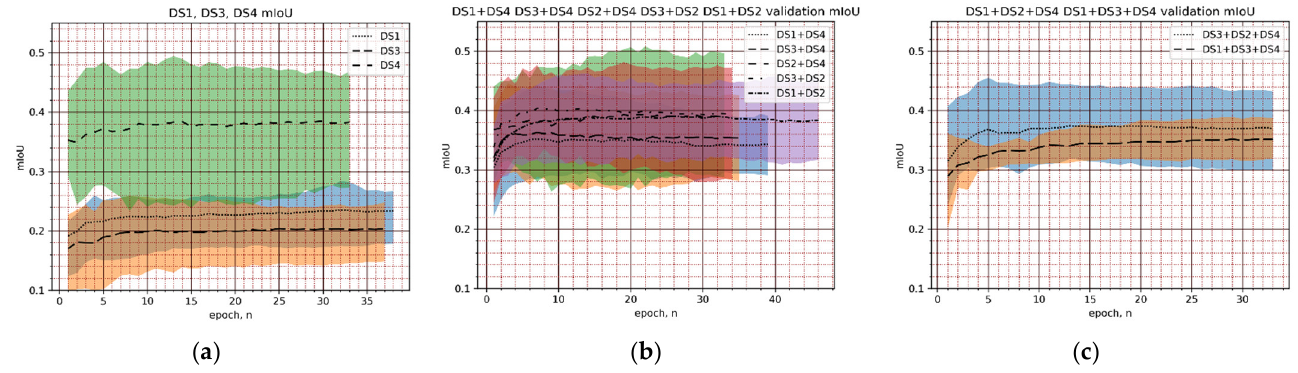
Figure 9. Mean intersection over union (mIoU) metric of validation dataset during training in 5-fold cross-validation analysis for the models with one ( a ), two ( b ), and three ( c ) data sources as input. The line represents the mean value of mIoU of all validation cases, and the colored area presents the difference between minimum and maximum values in different folds.